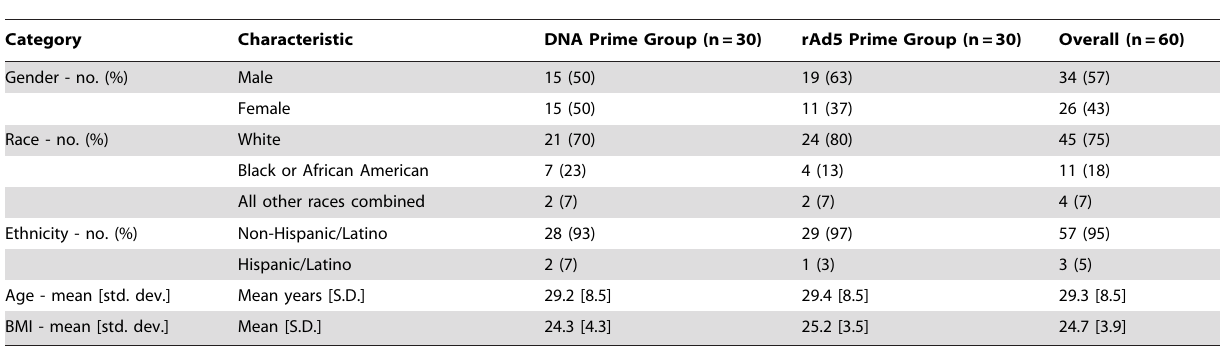
Table 1. VRC 011 Baseline Characteristics of Participants.